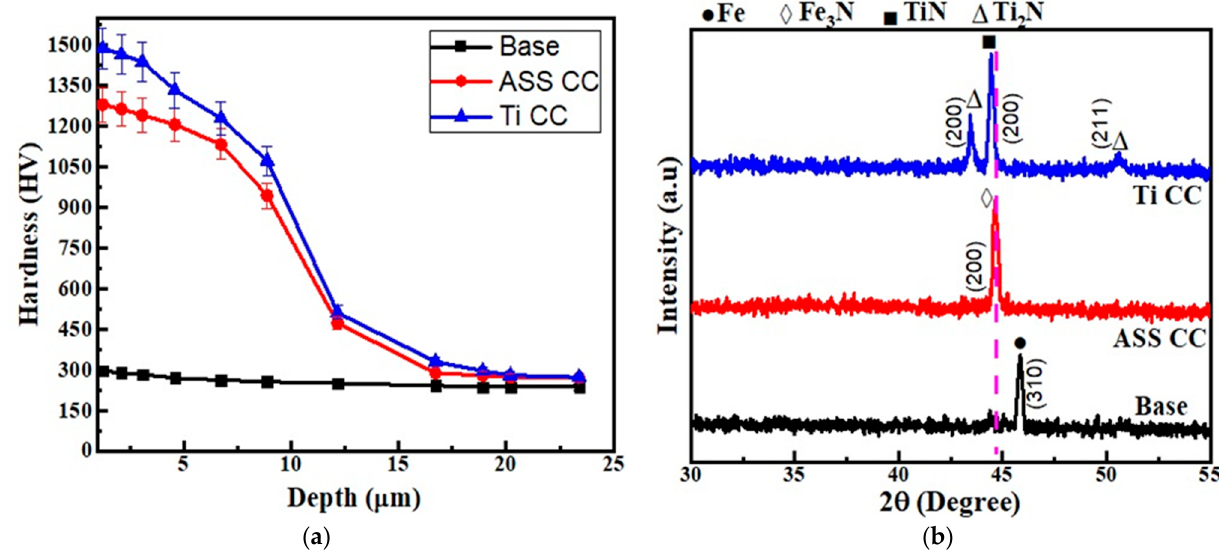
Figure 4. ( a ) Micro-hardness patterns of base and nitrided coupons and ( b ) XRD profile.